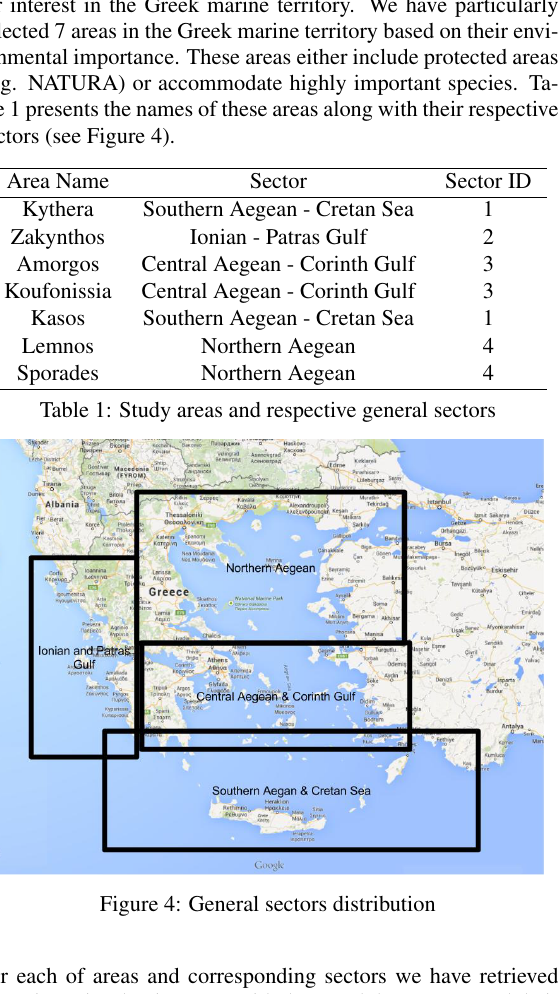
Figure 2: Example of Pie Charts (ShipType, ShipAge)